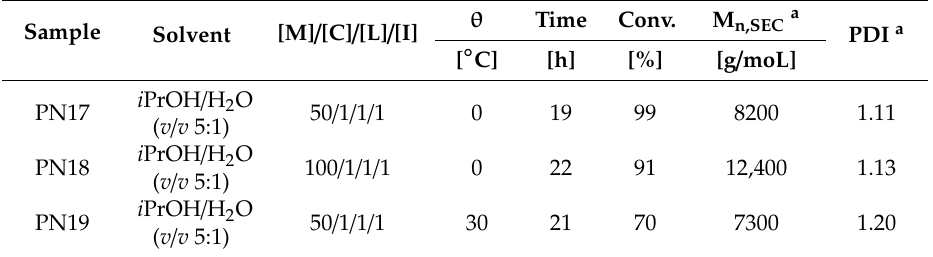
Table 5. ATRP of NIPAAm using the CuBr / Me 6 TREN catalyst complex and methyl-2-bromopropionate as initiator.